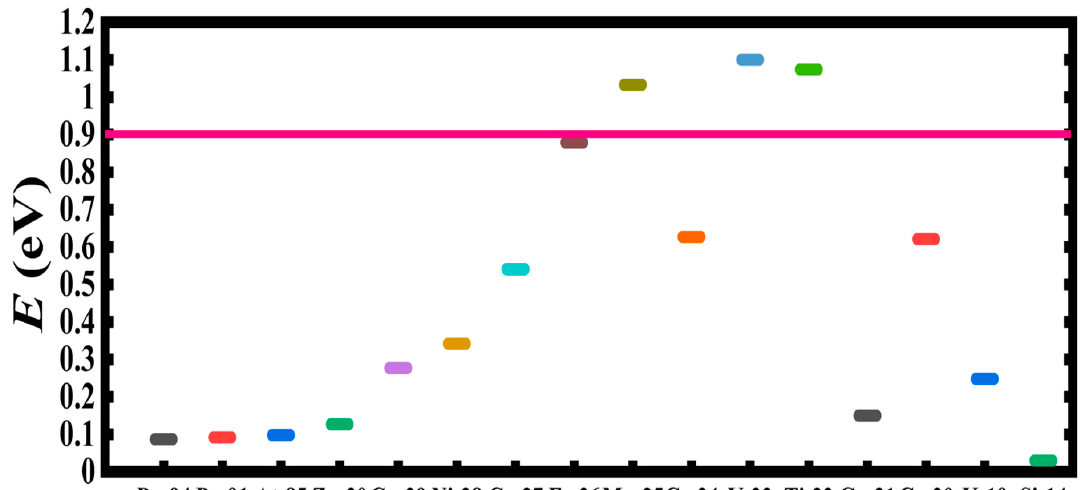
Figure 9. Transition state energy barrier reduction, E(eV), in ascending order of catalytic effectiveness for doubly-charged heavy systems, including C 60 and 24 carbon graphene (Gr24-6). The horizontal axis indicates the not-to-scale catalyzing systems, and the solid pink line represents the barrier energy position with no catalyst present.